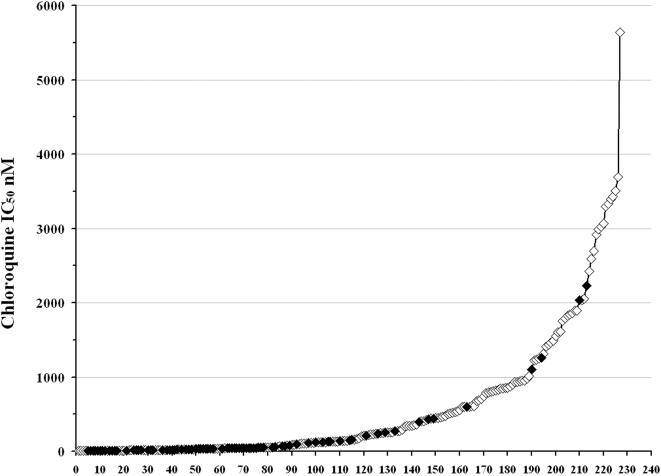
Distribution of isolate chloroquine IC50.81 Thai (closed diamonds) and 141 Indonesian (open diamonds) P. vivax isolates ranked in order of increasing chloroquine IC50.